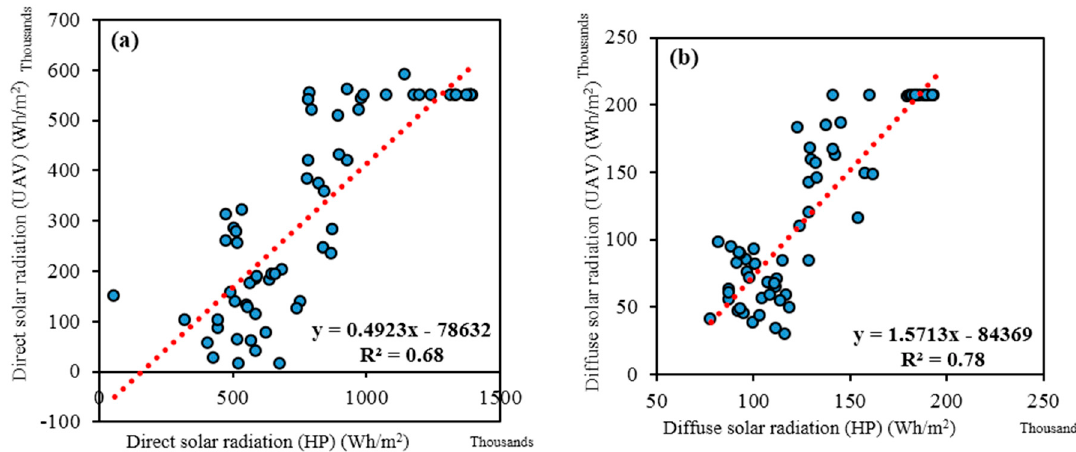
Figure 12. The correlation between the direct ( a ) and diffuse ( b ) potential solar radiation as derived from HP and the UAV (64 main plots) in W·h/m 2 for an entire growing season. Table 2. Summary table of regression statistics using HP and the UAV.